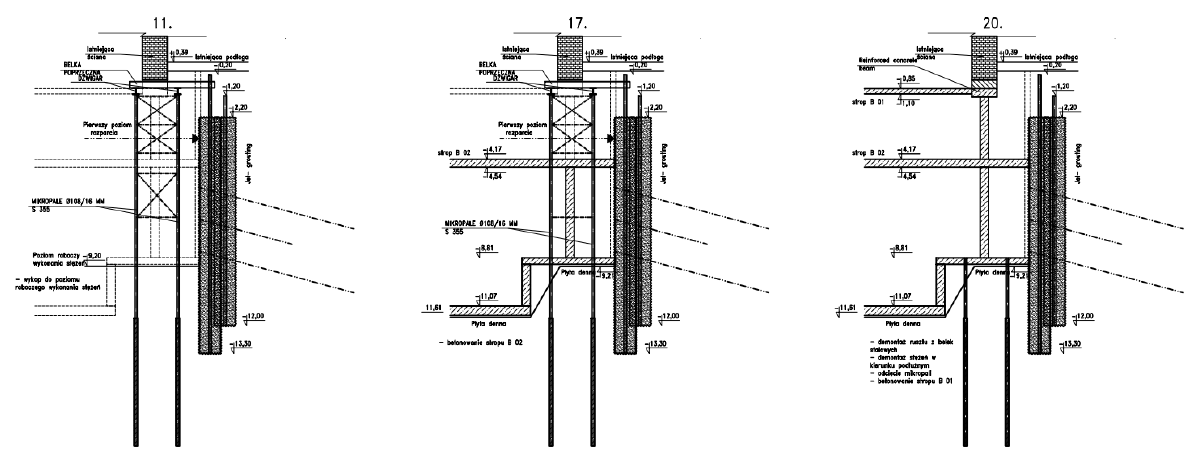
Figure 5. Cross section of micropile underpinning – selected phases.